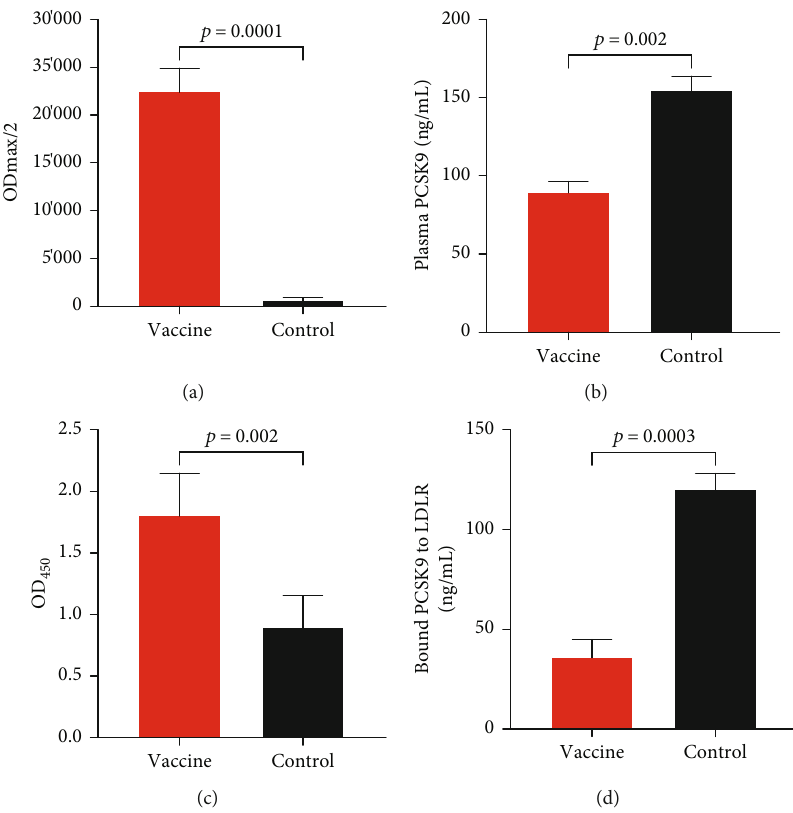
Figure 2: The function of liposomal anti-PCSK9 vaccine in rats upon 4 vaccinations. (a) Anti-PCSK9 peptide IgG titers ( OD /2 ) in max vaccinated and control rats ( n = 8 /group). (b) Concentrations of the plasma PCSK9 in vaccinated and control rats were 89 ± 7ng/mL and 154 ± 10ng/mL , respectively ( n = 3 replicates of the pooled samples of 8 rats per group). (c) Direct detection of vaccine-generated anti- PCSK9 antibodies targeting plasma PCSK9. Increased OD is indicative for evaluating the direct binding of anti-PCSK9 antibodies to 450 plasma PCSK9 from vaccinated and control rats ( n = 3 replicates of the pooled samples of 8 rats per group). (d) In vitro evaluation of PCSK9/LDLR interaction. Plasma sample of vaccine rats contained vaccine-generated anti-PCSK9 antibodies that could decrease PCSK9 interaction to LDLR by 30% when compared with the plasma sample of control rats ( n = 3 replicates of the pooled samples of 8 rats per group). Bars show mean values, error bars show ±